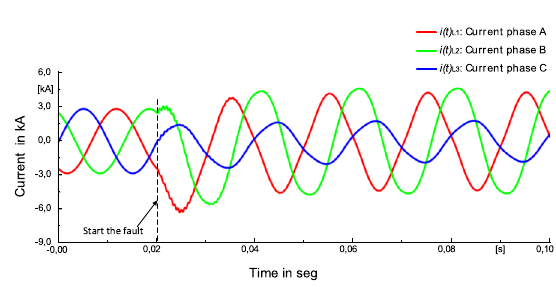
Fig. 2 SC-current behavior during a two-phase